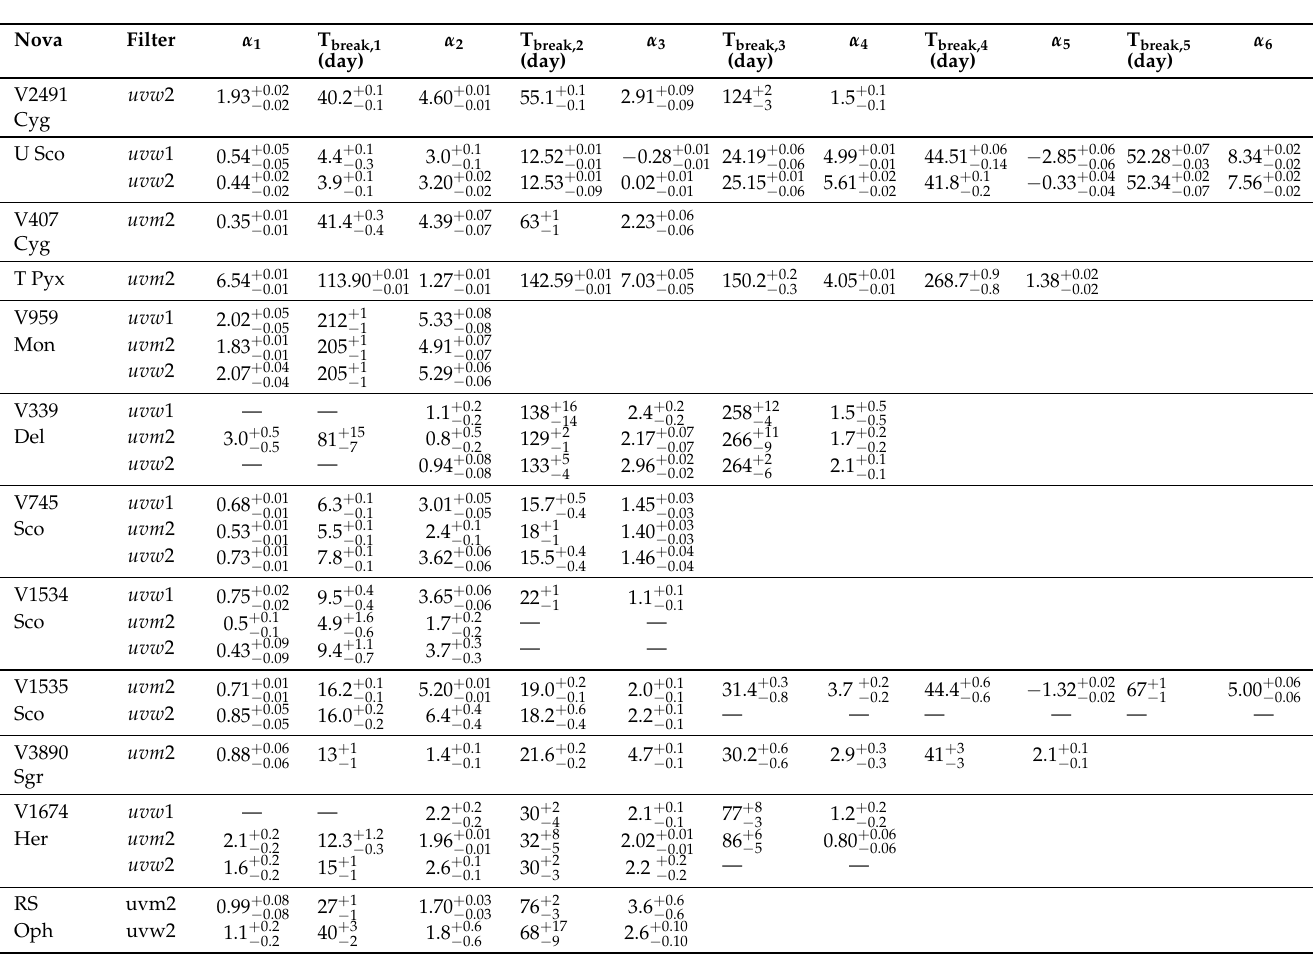
Table 2. Parameterising the UV light-curves as a series of power-law decays. The uncertainties on the fitted break times are given at the 90% level, and the power-law slopes are calculated using Equation (1). The errors on the slopes have been estimated using the uncertainties of the magnitudes from the